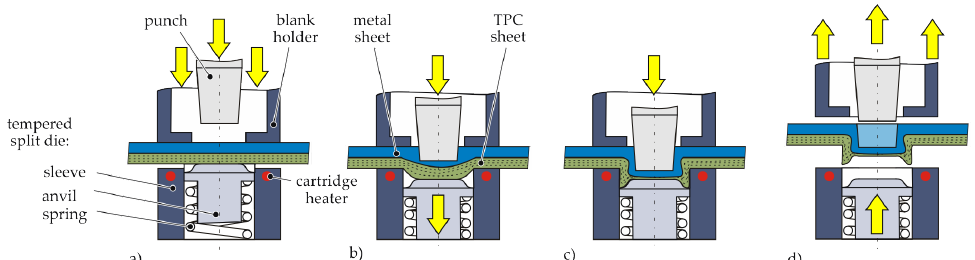
Figure 2. Process states of the thermally assisted clinching process [3]; ( a ) Positioning ( b ) Offsetting ( c ) Upsetting and Flow Pressing ( d ) Finished joint.